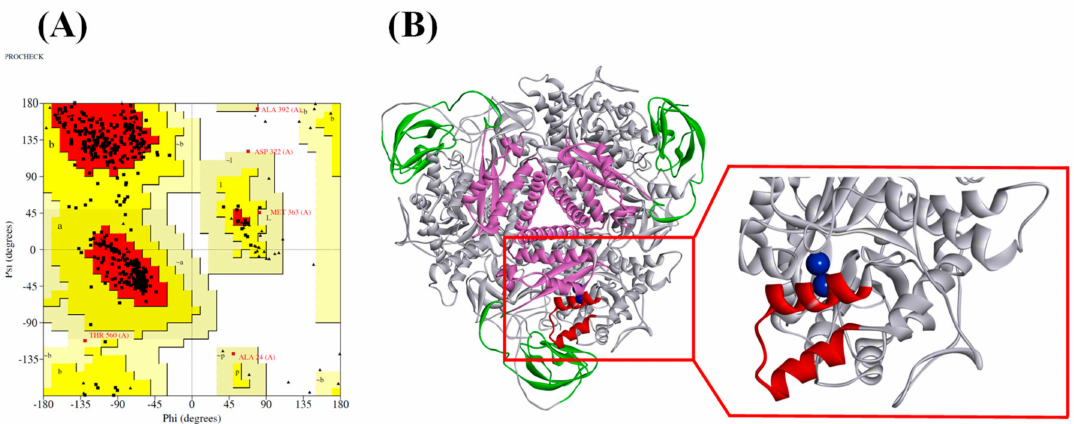
Figure 1. Ramachandran plots ( A ) and final three-dimensional (3D) structure of the ruminal metagenomic urease (UreC) homology model ( B ). Subunits of the ruminal metagenomic urease homology model are indicated by a di ff erent color; the trimer of alpha subunits (UreC) is depicted as grey, the beta subunits (UreB) as green, and the gamma subunits (UreA) as pink. The UreC structure of ruminal metagenomic urease is magnified in the rectangular window in which Ni pairs are shown as blue spheres and the flexible loop is depicted in